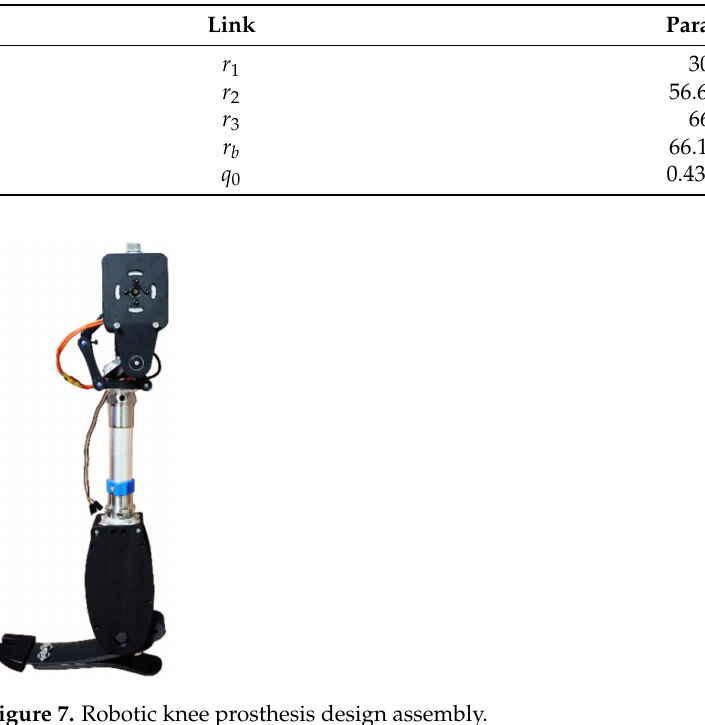
Table 5. Four-bar mechanism optimized parameters.